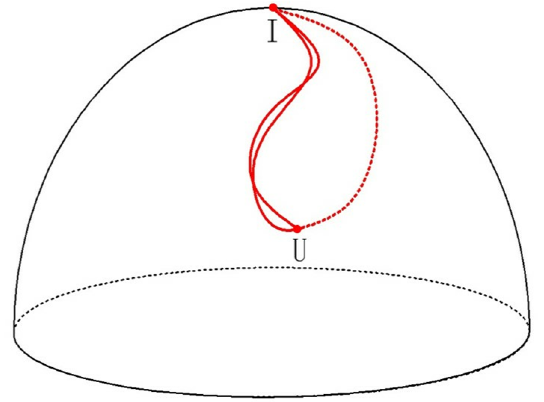
Figure 7 . Only the trajectories with minimal complexity (denoted by solid lines) contribute to the path integral, the contribution of the trajectory with large complexity (denoted by red dotted line) is exponentially suppressed by the factor e − ηC in eq.